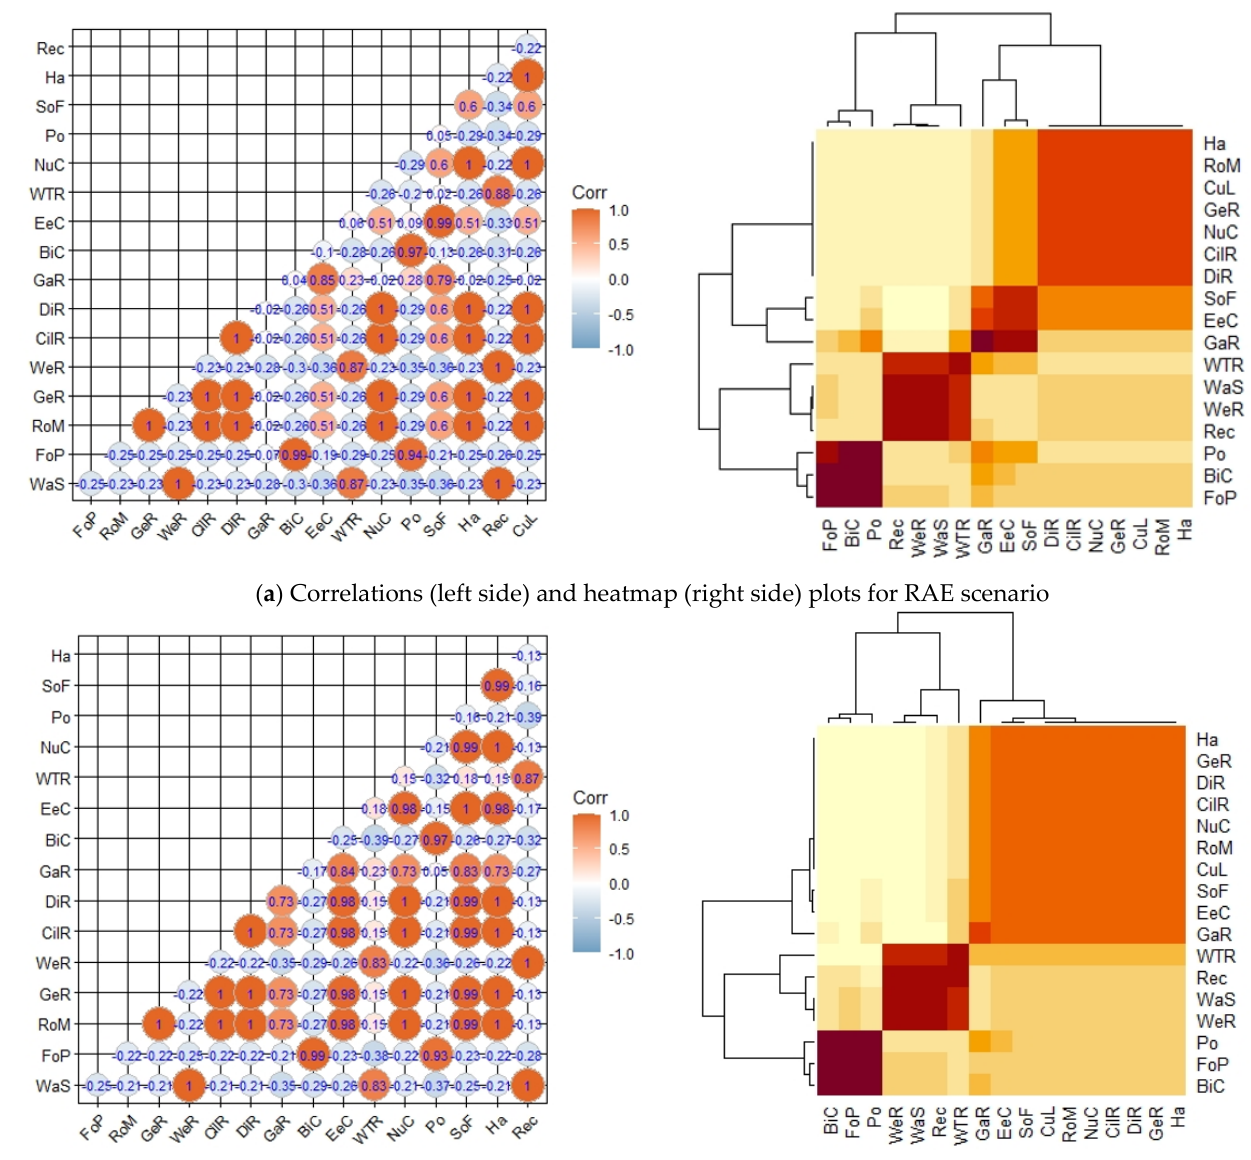
Figure 4. Correlations and heatmap plots under ( a ) and ( b ) present relationships between ES under RAE and LERC scenarios. Note: ( a ) is an ES (variables) factor map that is labeled with ES; these are selected as shown on the plane; ( b ) is a graph that shows the correlations between ES. Each ES is de- noted as follows: water supply (WaS); food production (FoP); raw materials (RoM); genetic resources (GeR); water regulation (WeR); climate regulation (CilR); disturbance regulation (DiR); gas regulation (GaR); biological control (BiC); erosion control (EeC); water treatment (WTR); nutrient cycling; (NuC); pollination (Po); soil formation (SoF); habitat/refuge (Ha); recreation (Rec); cultural (CuL). As per the number and color differences observed in Figure 4a,b, the trade-offs (nega- tive correlations) between ES are very high under RAE, whereas they are very low under LERC. However, synergies (the number of ES positively correlated) under the LERC